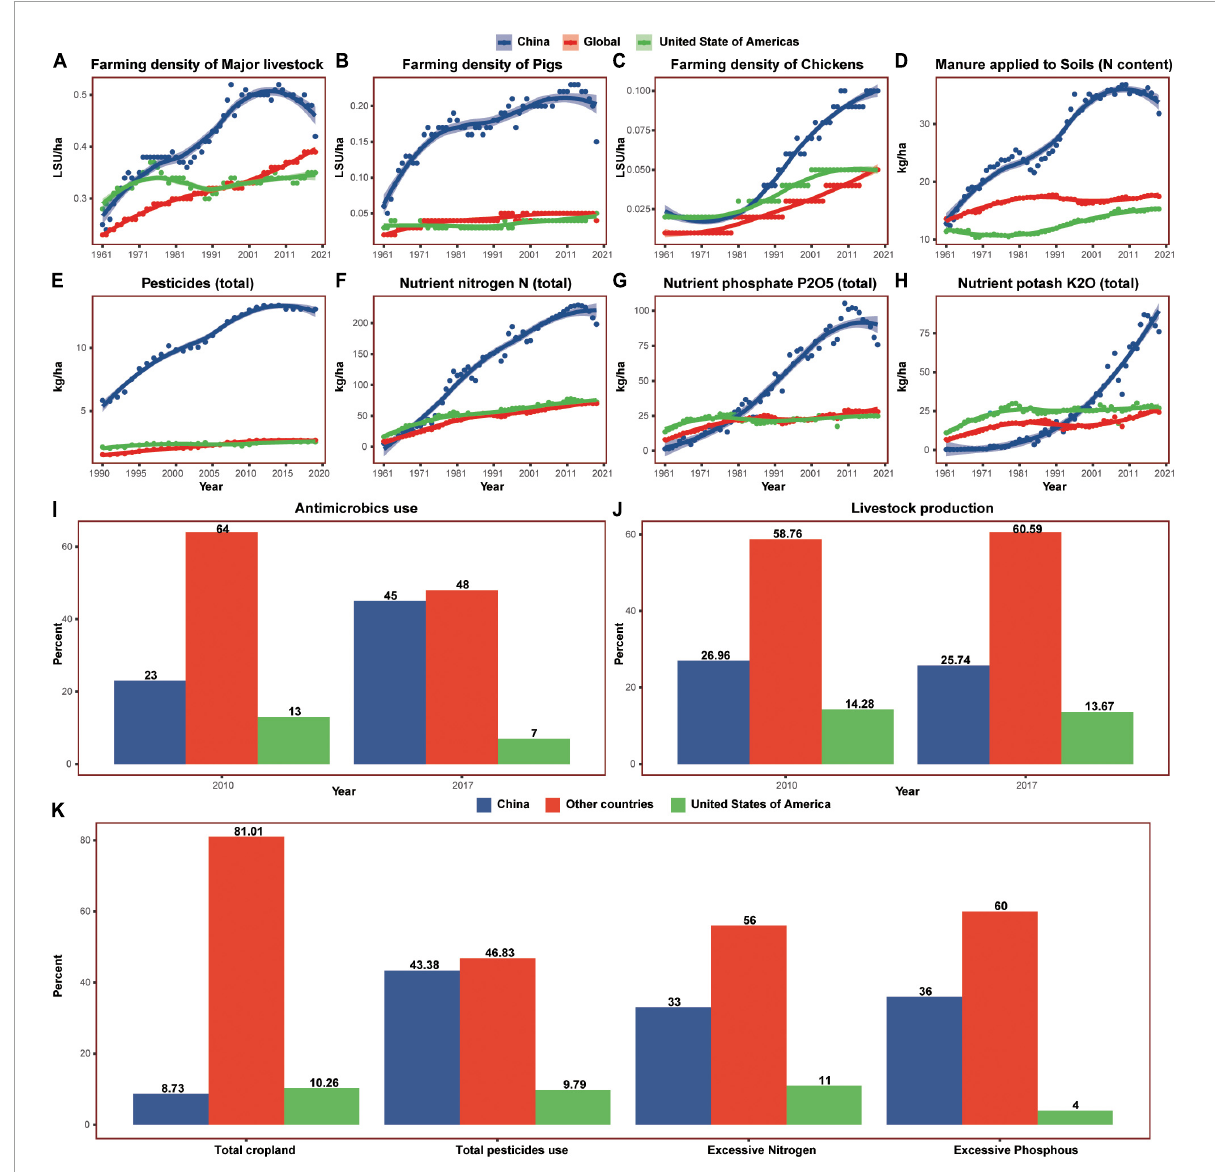
FIGURE9 The changes of animal and vegetal foods production in China, the United States of America, and the world in the past six decades. (A–C) Showed the farming density of major livestock, pigs, and chickens, individually; (D) showed the manure applied to soils per hectare; (E) showed the total pesticides used for per hectare; (F–H) showed the usage of chemical fertilizer nitrogen, phosphate, and potash, respectively. (I) Showed the proportion of total antimicrobics usage in food animals and (J) showed the proportion of livestock production during the same time. (K) Showed the proportion of total cropland, pesticides use, excessive nitrogen and excessive phosphorus in 2014. Shaded sections indicate 95% uncertainty intervals, LSU, livestock unit; ha,